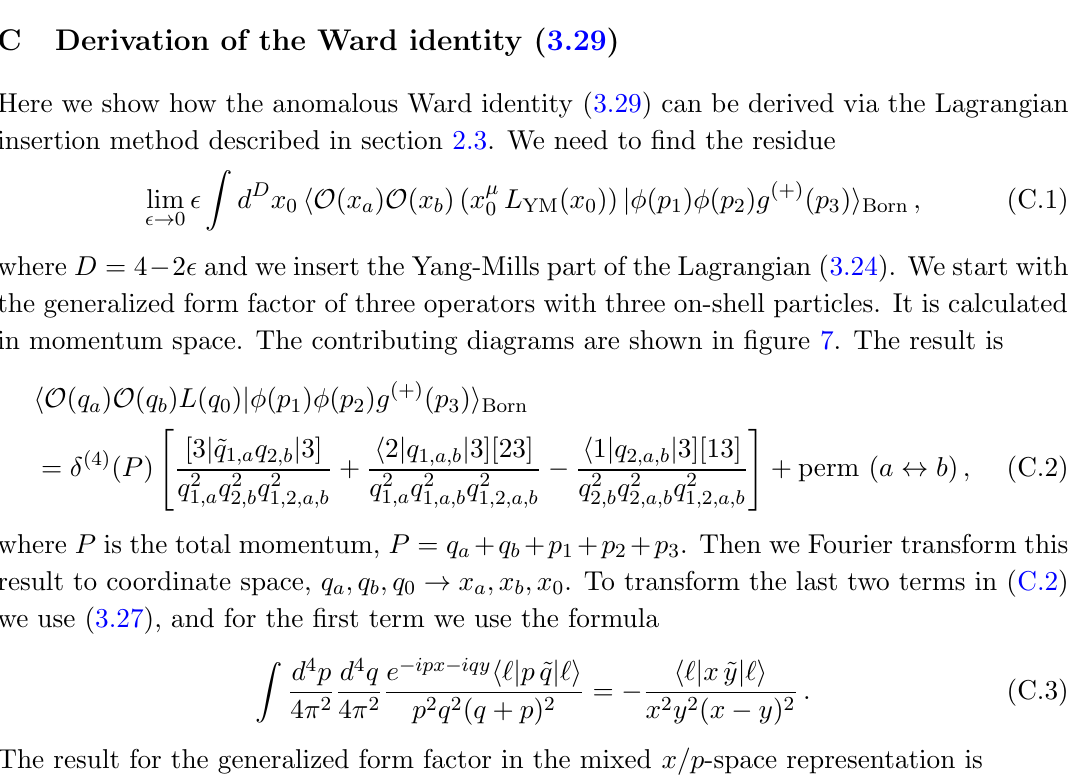
Figure 7 . Feynman graphs for the generalized form factor with Lagrangian insertion